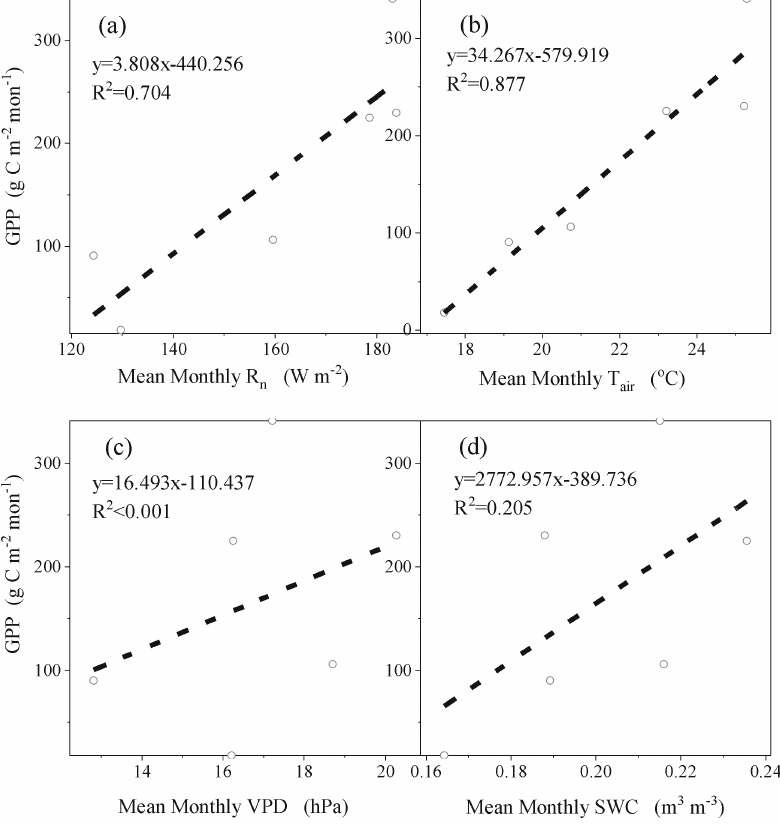
Fig 7. The relationship between total monthly GPP (gross primary production) and mean monthly R n (net solar radiation), T air (air temperature), VPD (vapor pressure deficit) and SWC (soil water content),